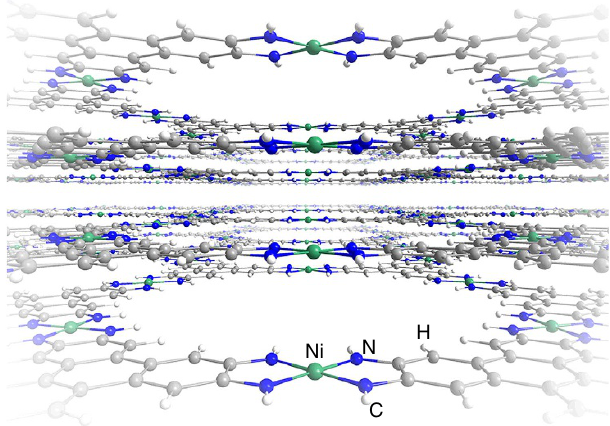
Figure 1 | Ni 3 (HITP) 2 structure. Perspective view of the two-dimensional layered structure of Ni 3 (HITP) 2 (ref.